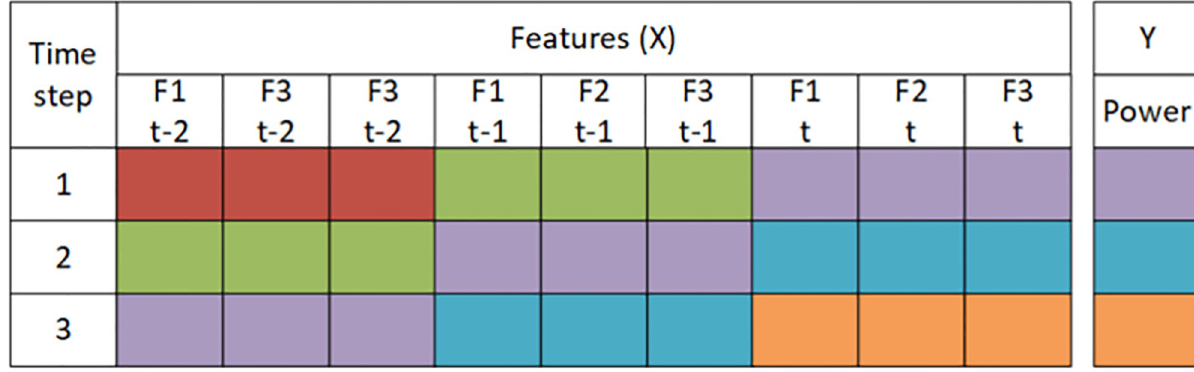
Fig 3. This figure illustrates the form of the dataset for lookback = 3.